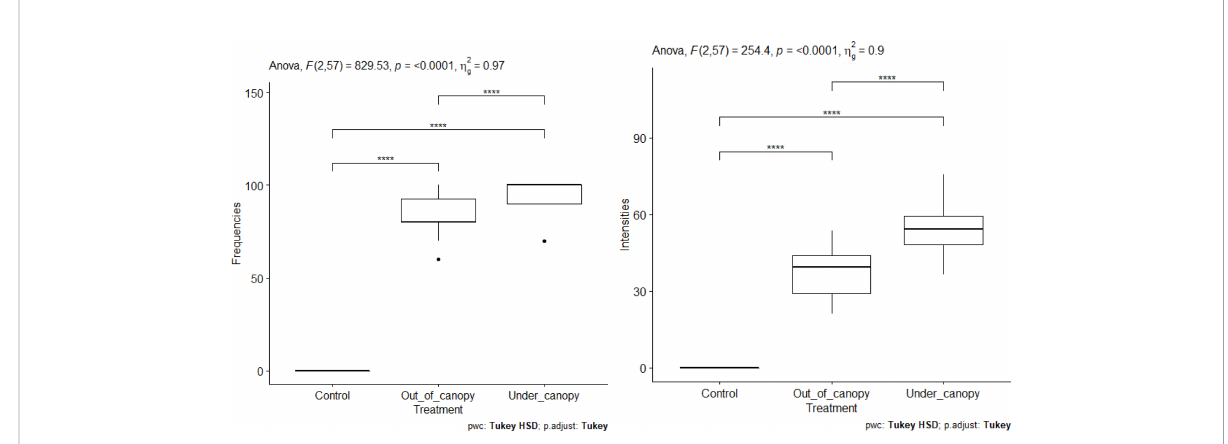
FIGURE 12 Frequencies of mycorrhization and intensities of mycorrhization according to treatment out of the tree canopy and under the tree canopy. "****" = Statistically signi fi cant difference